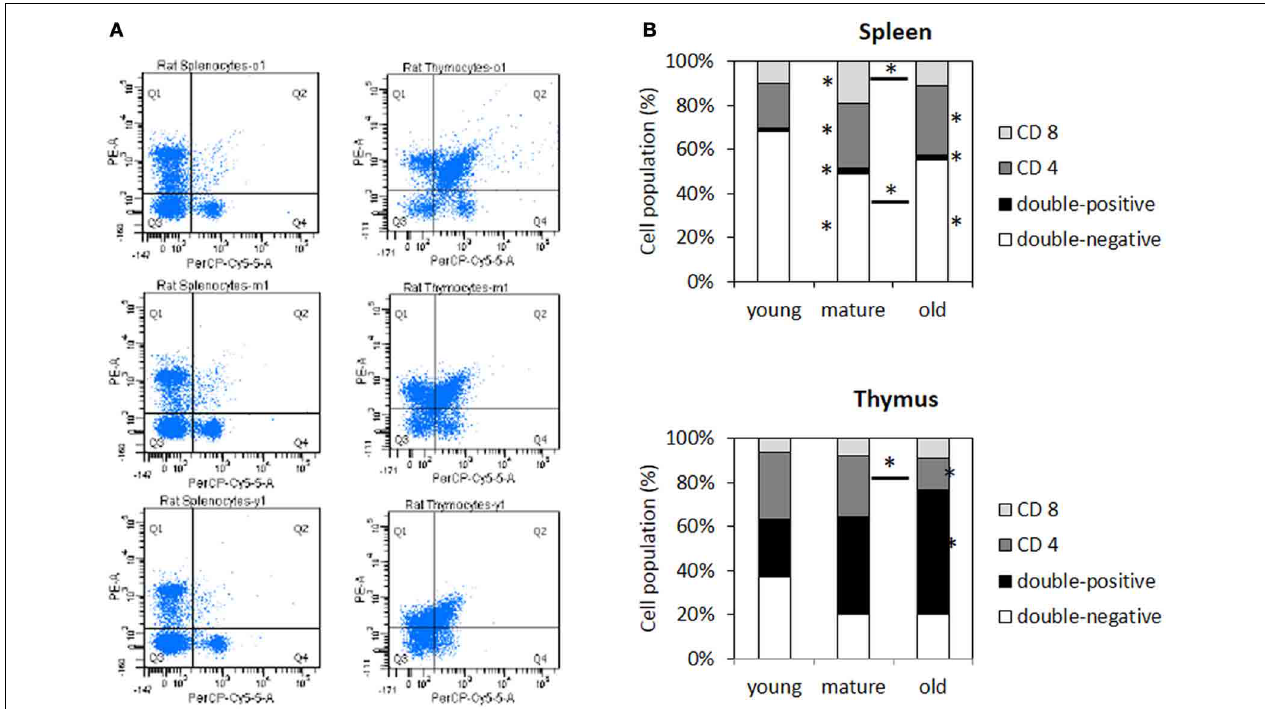
FIGURE 8 | Changes in the composition of T cell populations in the spleen and thymus of aging animals. (A) Representative plots of PE-CD4 vs. PerCP-CD8A. (B) The bar graphs represent the percentage of the total cell populations in four different quadrants. Each data point represents an average